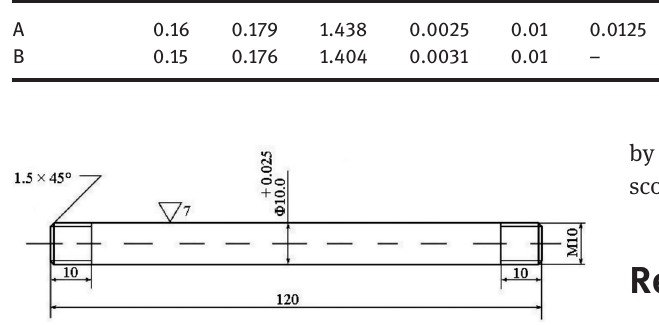
Table 1: Chemical composition of steel samples (mass%). Sample no.